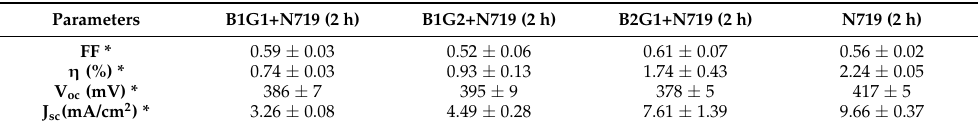
Table 6. Photovoltaic performance parameters of DSSCs based on the use of COF RIO-60 as an interface between TiO 2 and the reference dye N719 for the best-performance batch under simulated AM 1.5G illumination at 100 mW/cm 2 . ( The presented results correspond to the best-performing cell ).